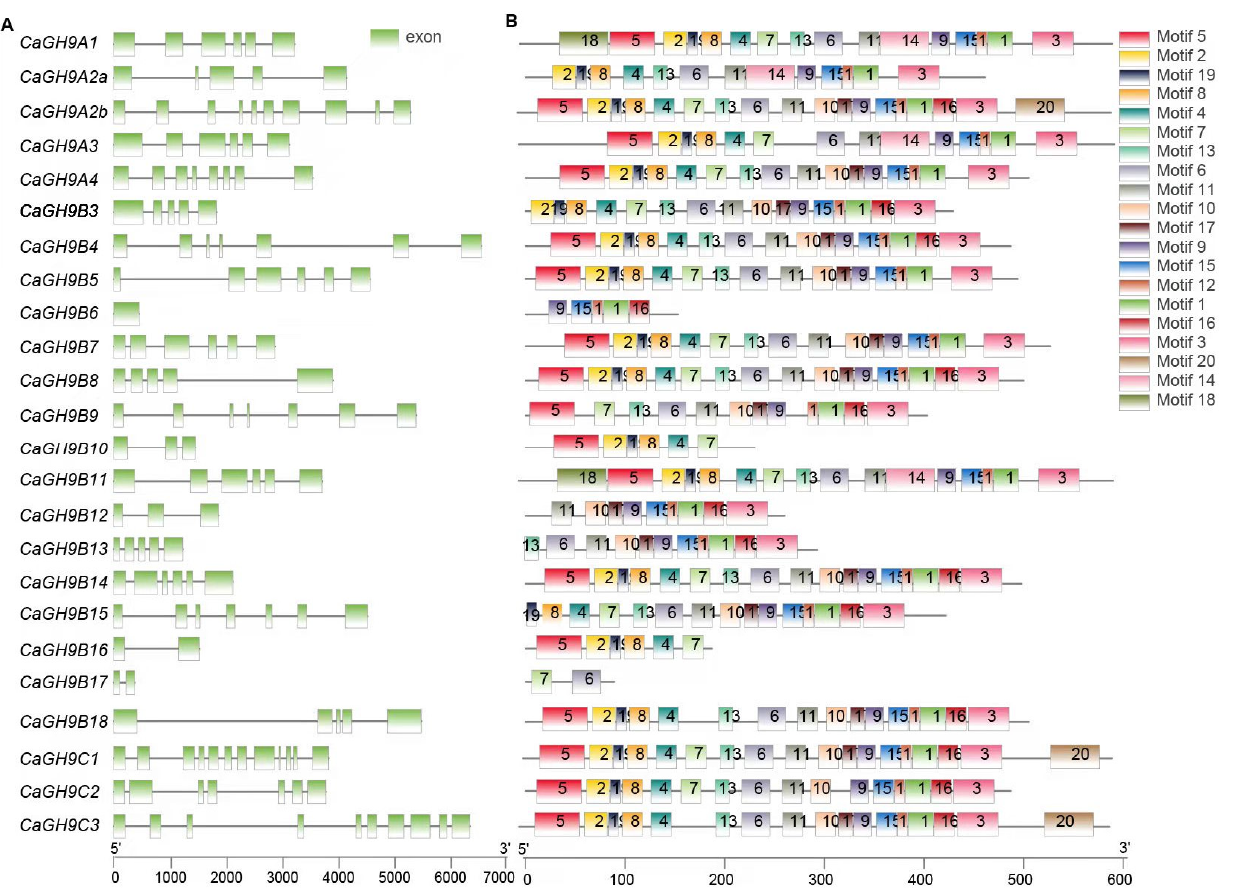
Figure 3. Gene structure and conserved motif of GH9 family members from pepper ( Capsicum annum ). ( A ) Gene structure. Green blocks represent exons and gray lines represent introns; ( B ) Distribution of conserved motifs of GH9 members in pepper.